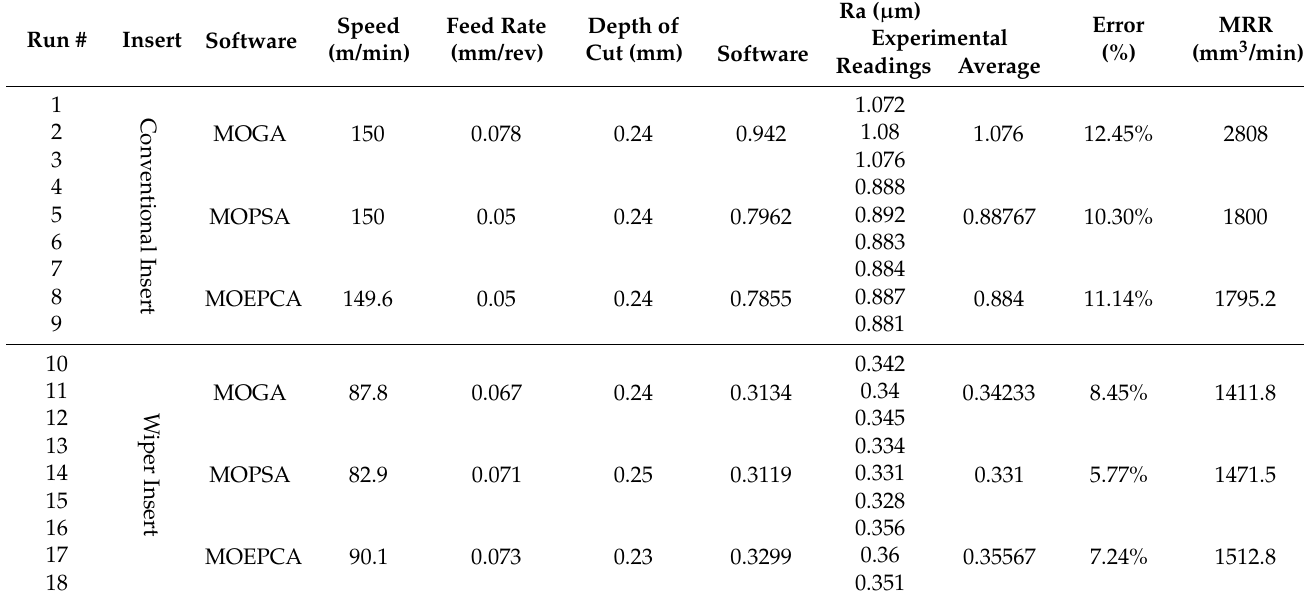
Table 9. Experiments for validation and verification (VAL/VER) of optimal conditions for wiper and conventional inserts.